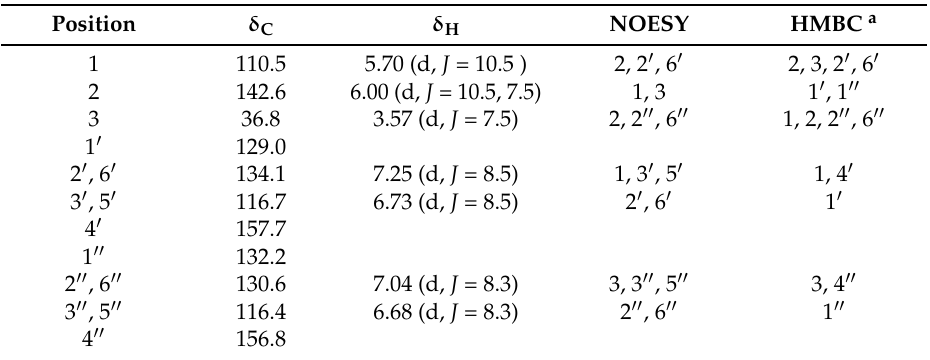
Figure 2. Significant NOESY ( ) and HMBC ( ) correlations of 1 . Figure 3. Significant NOESY ( ) and HMBC ( ) correlations of 2 . Table 1. NMR data (CD 3 OD) of 1 . δ in ppm, J in Hz. Table 2. NMR data (CDCl 3 ) of 2 . δ in ppm, J in Hz.